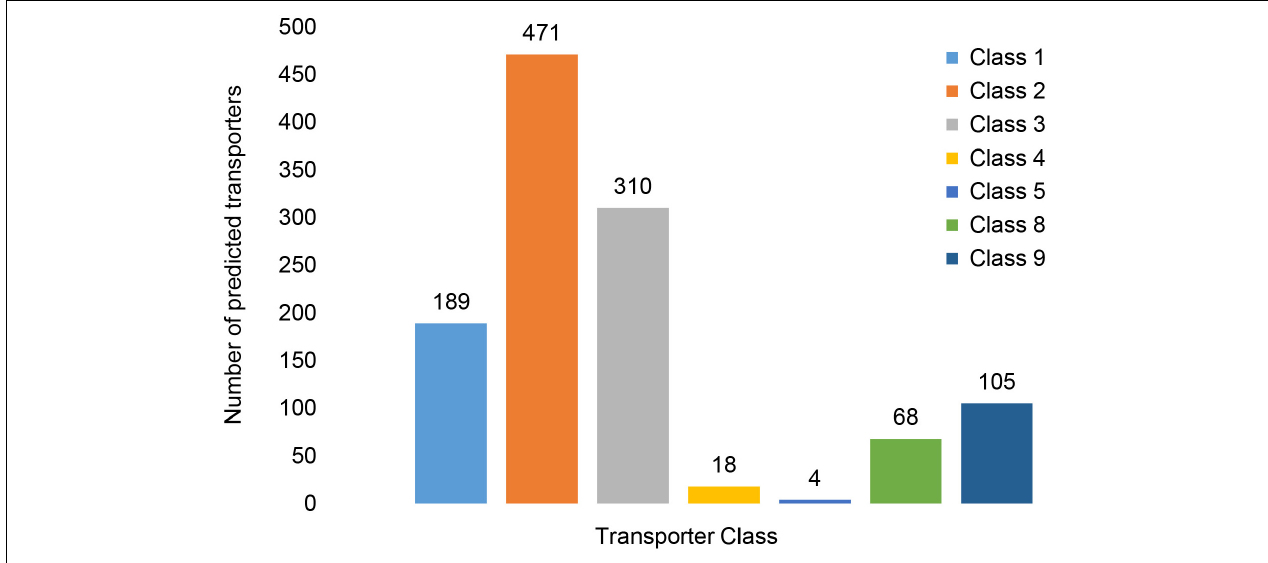
FIGURE 10 | Distribution of putative transporter genes across Transporter Classes. The transporter classes present included Class1: Channels/Pores, Class 2: Electrochemical Potential-driven Transporters, Class 3: Primary Active Transporters, Class 4: Group Translocators, Class 8: Accessory Factors Involved in Transport and Class 9: Incompletely Characterized Transport